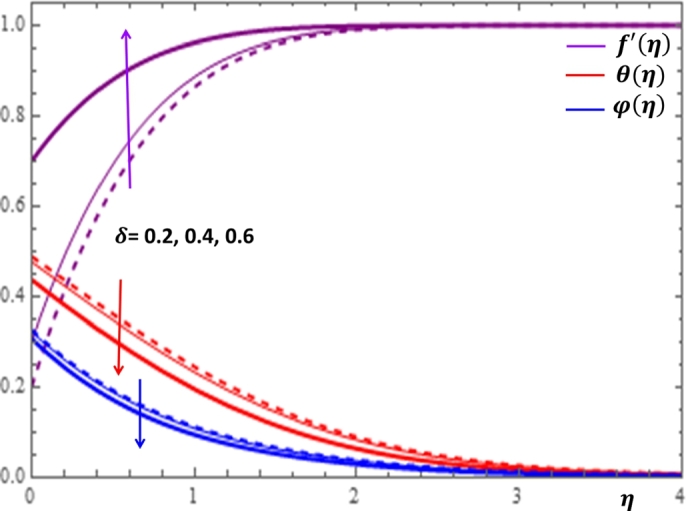
Impacts of velocity ratio δ (δ > 0) on f′(η), θ(η) and φ(η).